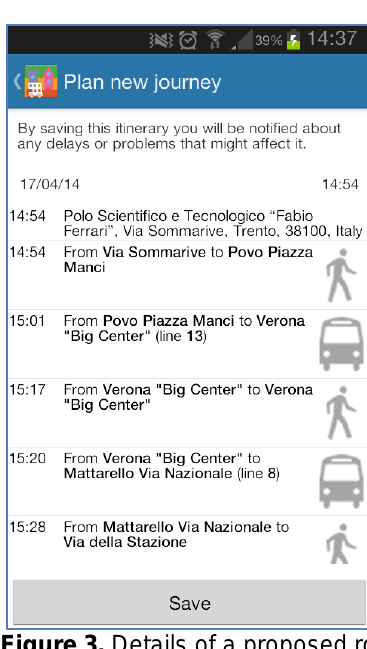
Figure 3. Details of a proposed